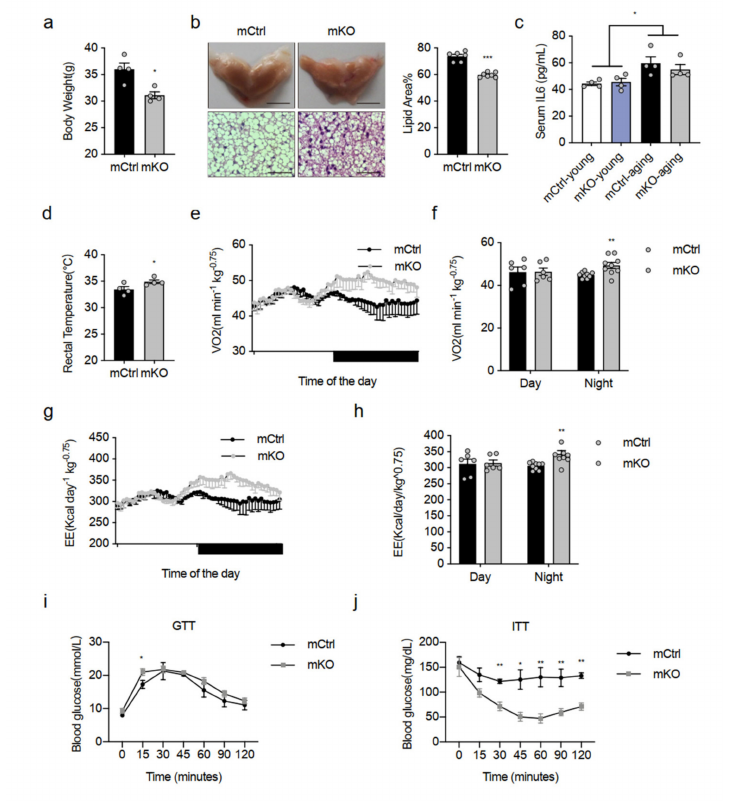
Figure 7. Deletion of Islr exerts beneficial metabolic effects in middle-aged mice: ( a ) body weights of the mCtrl and mKO mice at the age of 10 months (n = 4); ( b ) representative BAT tissues, H&E staining of BAT sections, and quantification of lipid area from mCtrl and mKO mice at the age of 10 months (n = 6–7); scale bar: 0.5 cm and 50 µ m; ( c ) the level of serum IL-6 in young and middle-aged mCtrl and mKO mice (n = 4); ( d ) quantification of the core body temperatures of mCtrl and mKO mice (n = 4); ( e , f ) indirect calorimetric analysis of VO 2 ( e ) and quantification of VO 2 ( f ) of mCtrl and mKO mice at the age of 10 months (n = 6–9); ( g , h ) indirect calorimetric analysis of EE ( g ) and quantification of EE ( h ) of mCtrl and mKO mice at the age of 10 months (n = 6–9); ( i ) glucose tolerance test of the mCtrl and mKO mice at the age of 10 months (n = 5–6); ( j ) insulin tolerance test of the mCtrl and mKO mice at the age of 10 months (n = 4). Error bars represent SEMs, * p < 0.05, ** p < 0.01, and *** p < 0.001, as determined by two-tailed Student’s t